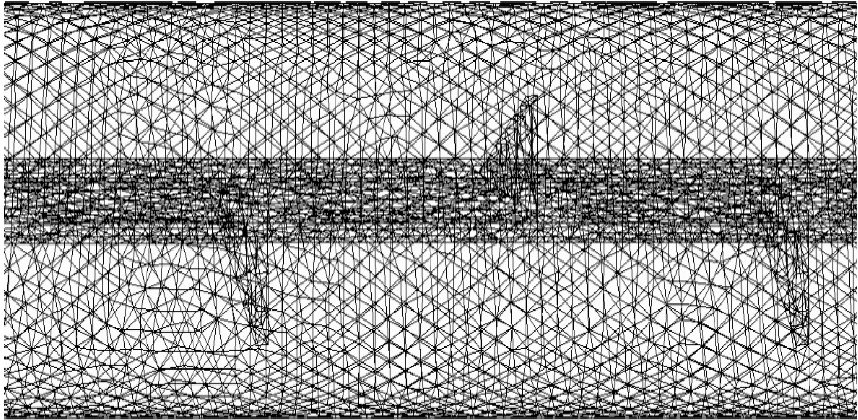
Figure 2. Grid Figure 2. Grid generation.